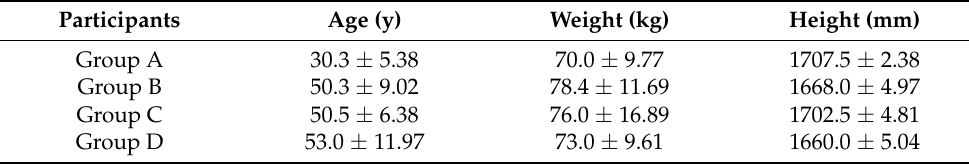
Table 1. Mean parameters and SD for groups A ( n = 8), B ( n =10), C ( n = 4), and D ( n = 4).